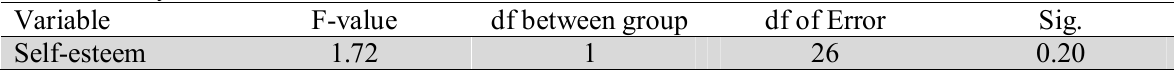
The summary of Levin test